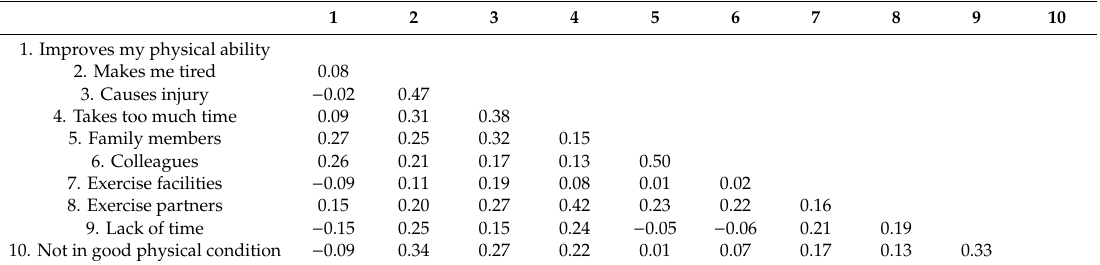
Table 2. Correlations among exogenous variables ( N = 175).